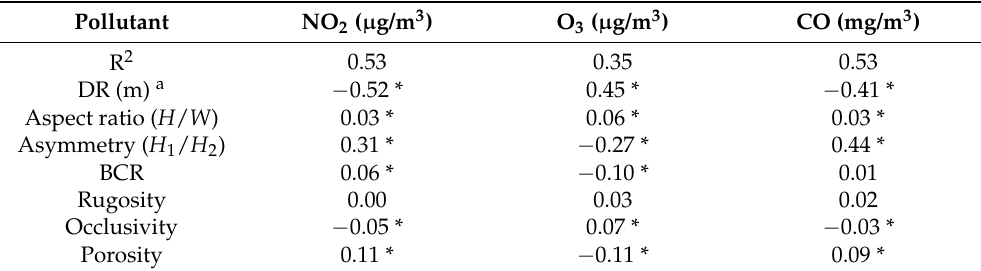
a The values in the table represent the standardized coefficients of the independent variables. Data with the “*”symbol show significant correlation. To avoid multi hypothesis testing, the p value has passed the Bonferroni test (i.e., p < 0.05/7).